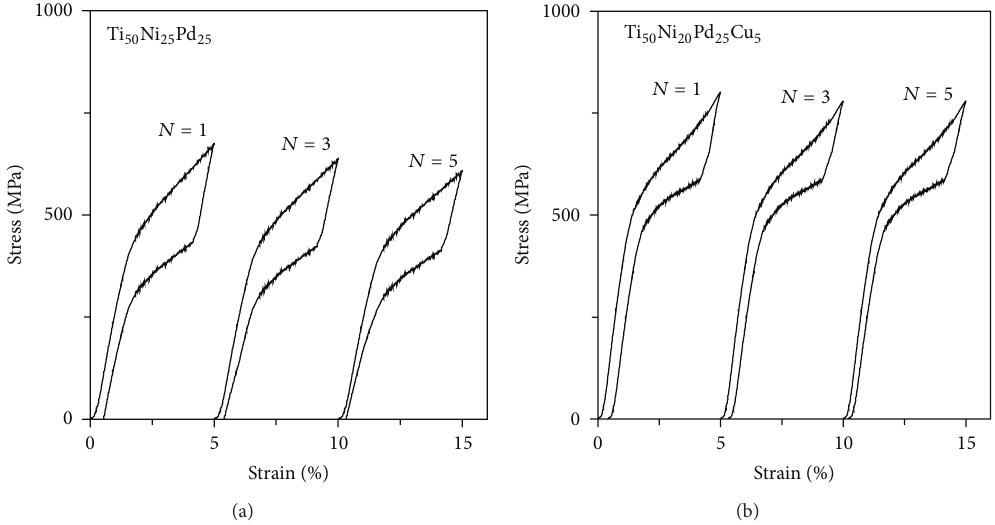
Figure 4: Tensile stress-strain curves (loading and unloading) tested in the austenite condition, 50 ∘ C above A 𝑓 of (a) Ti 50 Ni 25 Pd 25 and (b) Ti 50 Ni 20 Pd 25 Cu 5 alloys. “ 𝑁 ” represents number of